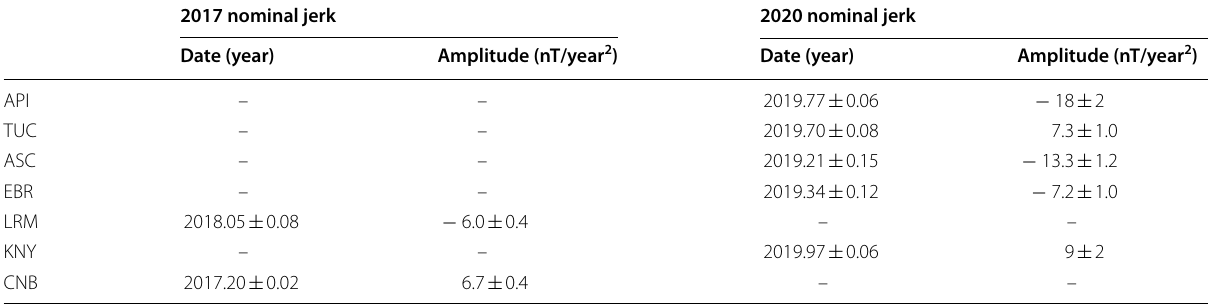
Positive amplitudes denote V‑shapes, while negative amplitudes denote Λ‑shapes of the SV trend. The "–" symbol indicates that the jerk was not evident at that observatory or not enough data are available after the